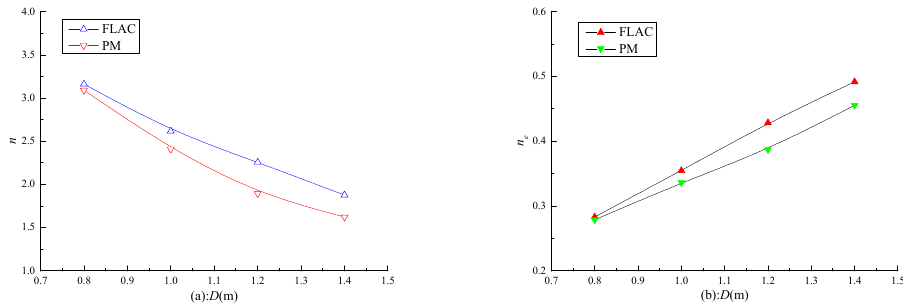
Figure 8. ( a ). The pile–soil stress ratio vs. D . ( b ) The load sharing ratio vs. D